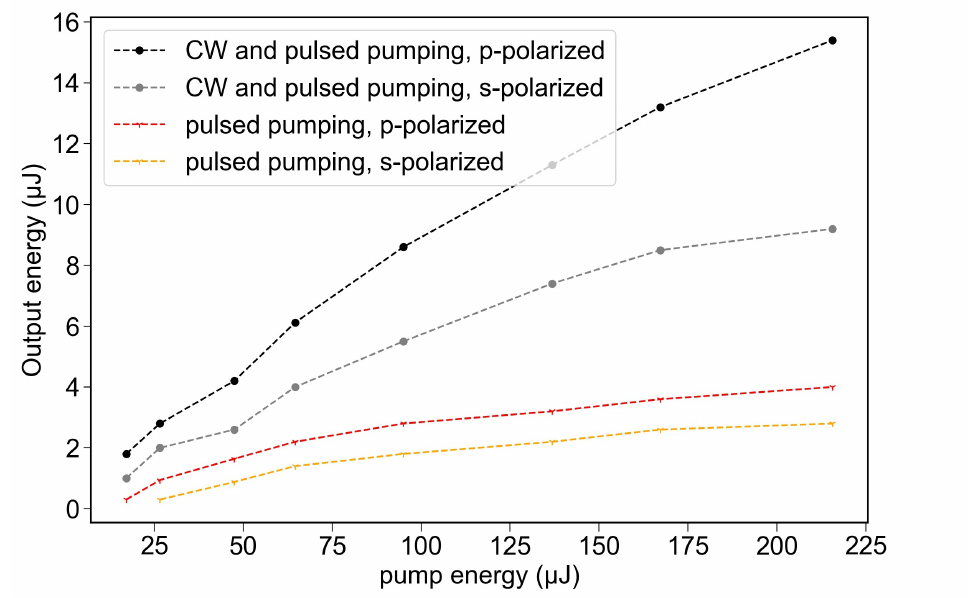
Figure 6. Ti:sapphire laser pulse energy as a function of pump pulse energy.